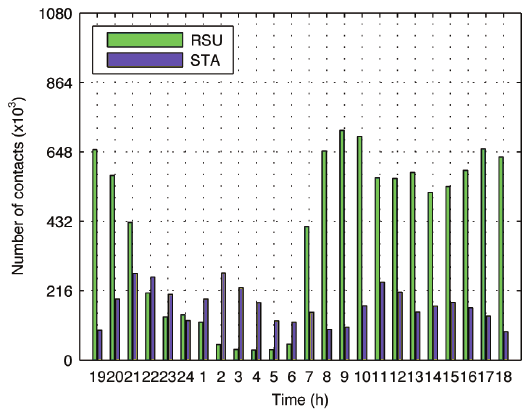
Figure 11. Mobility of